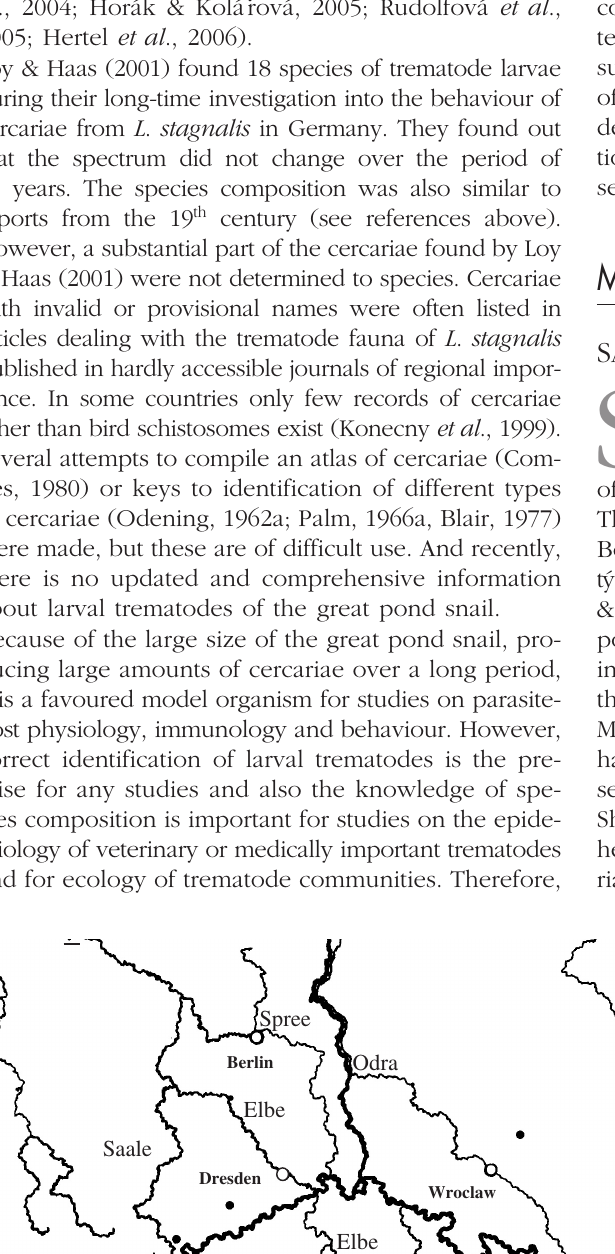
Fig. 1. – Survey of localities ( ● ) where samples of snails were